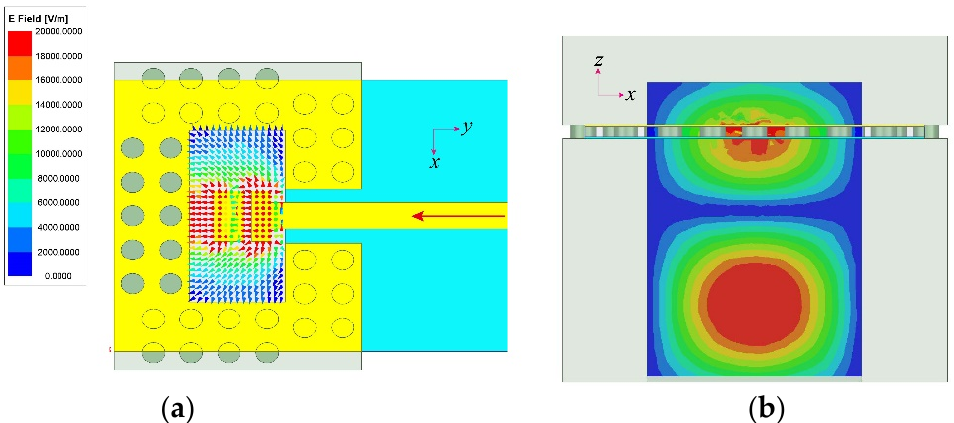
Figure 5. The electric field distribution of the transition. ( a ) The vector E-field of the probe. ( b ) The cross-sectional E-field distribution in rectangular waveguide. Table 1. The dimensions of the proposed microstrip to waveguide transition. (Unit: mm).